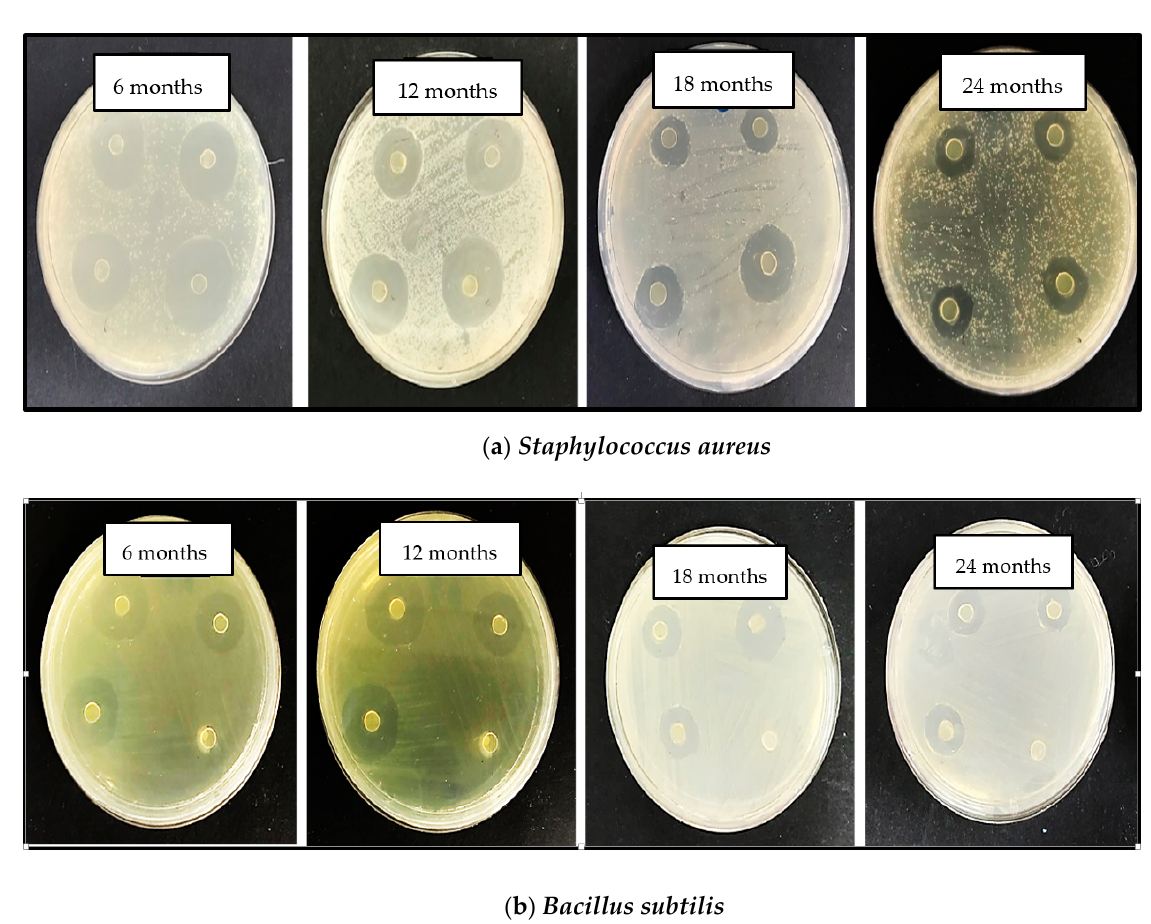
Figure 9. Photographic images of inhibition zone measurement results of seaweed–neem film irradiated at optimized dosage of 1.5 kGy against; ( a ) Staphylococcus aureus ; ( b ) Bacillus subtilis .